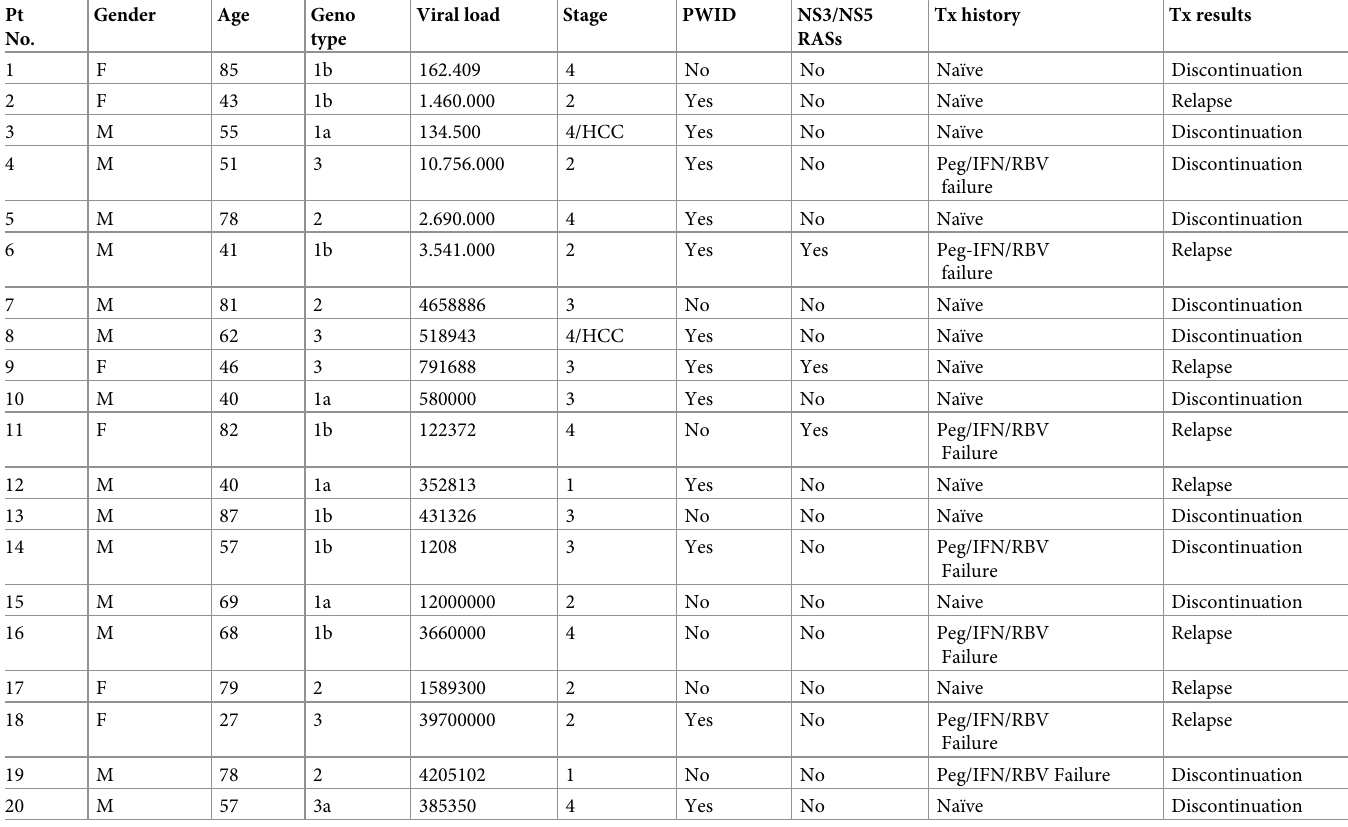
Table 4. Baseline characteristics of patients with virological